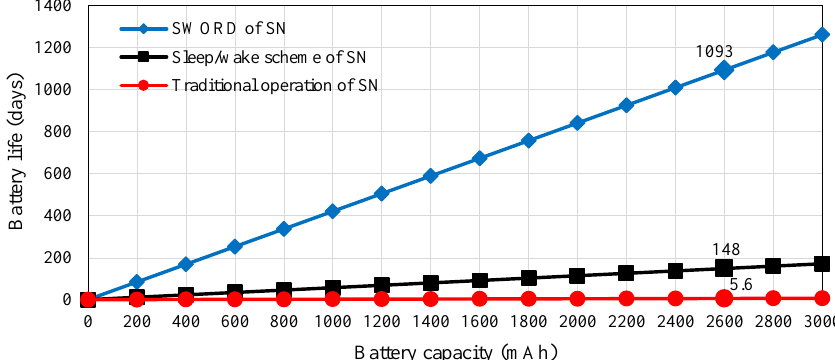
Figure 17. Estimated battery life versus battery capacity in the sensor node based on the SWORD algorithm, sleep/wake scheme, and traditional operation.